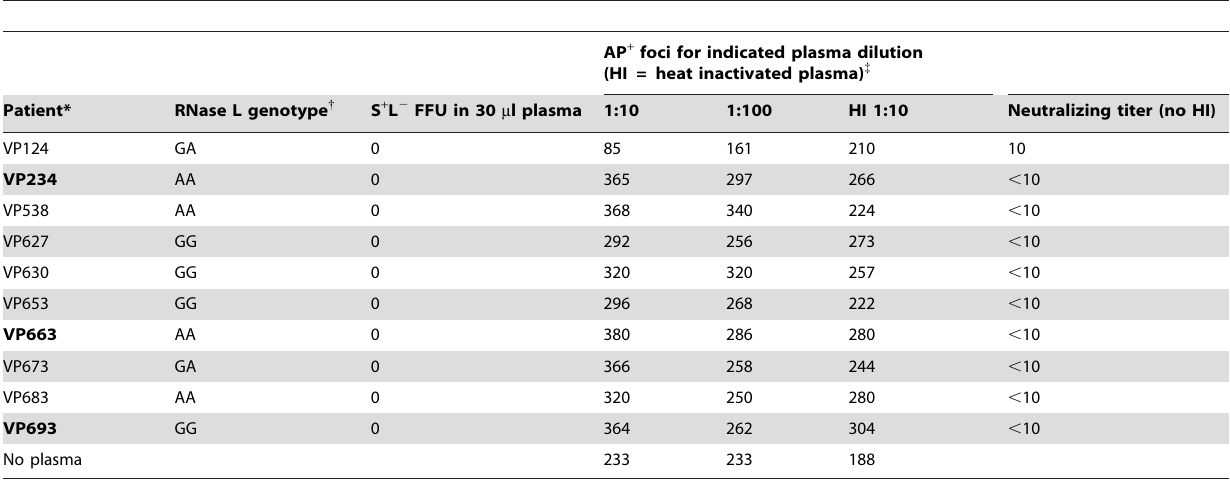
*Patient identifiers shown in bold indicate patients who had previously tested positive for XMRV. See Discussion for details. { Nucleotides at position 1385 of the RNase L coding regions of both patient alleles are shown. A G1385A transition at position 1385 results in a glutamine instead of arginine at amino acid position 462 (R462Q) of RNase L, which has been associated with higher XMRV infection rates in homozygous R462Q patients in some studies [1]. { The virus neutralization assay was performed by incubating XMRV-pseudotype LAPSN vector (harvested from human cells infected with XMRV and the LAPSN vector) with plasma samples at the indicated dilutions, or with phosphate-buffered saline as a no plasma control, for 30 min at room temperature. The remaining LAPSN virus was measured by infection of HTX human fibrosarcoma cells and staining for foci of AP + cells two days later. Plasma heat inactivation was performed at 56 u C for 30